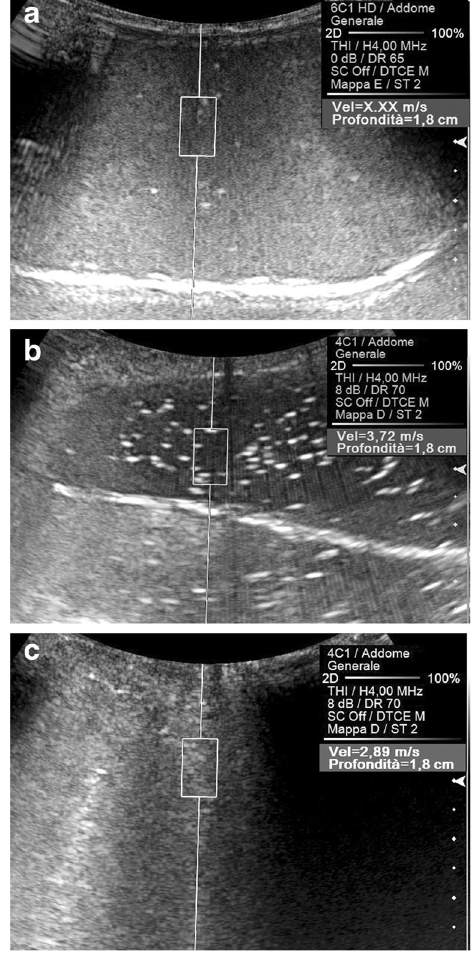
Fig. 2 Effect of the elasticity of the target on the speed of propagation of the shear waves. Shear waves do not generate (SWV not measurable: B X.XX ^ ) in pure water ( a ) and travel quite fast (3.72 m/s) in oil ( b ). In a water-oil emulsion ( c ) the SWV (2.89 m/s) is lower than in pure